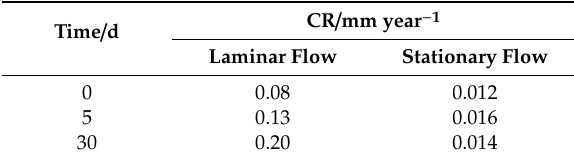
Table 6. Corrosion rate of AA6061-T6 in Caribbean seawater from the Cozumel Channel under laminar and stationary